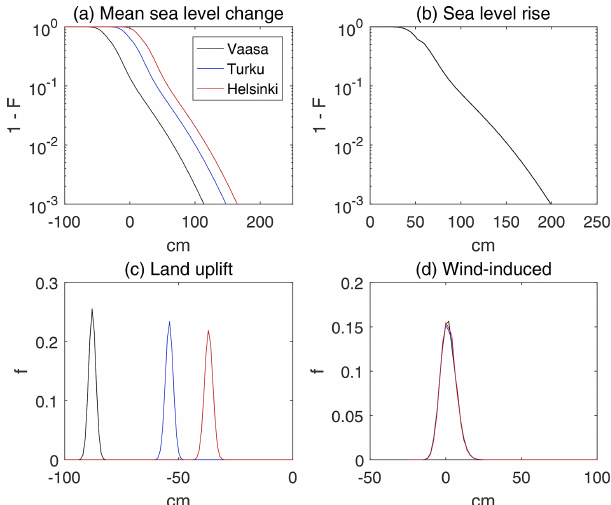
Figure 7. Probability distributions of projected mean sea level change (a) and its components (b–d) in Vaasa, Turku, and Helsinki under the medium-emission scenario (RCP4.5/SSP2-4.5), 2100 rel- ative to 1995–2014. The distributions (a) and (b) are complemen- tary cumulative distribution functions (1 − F ), while (c) and (d) are probability density functions ( f